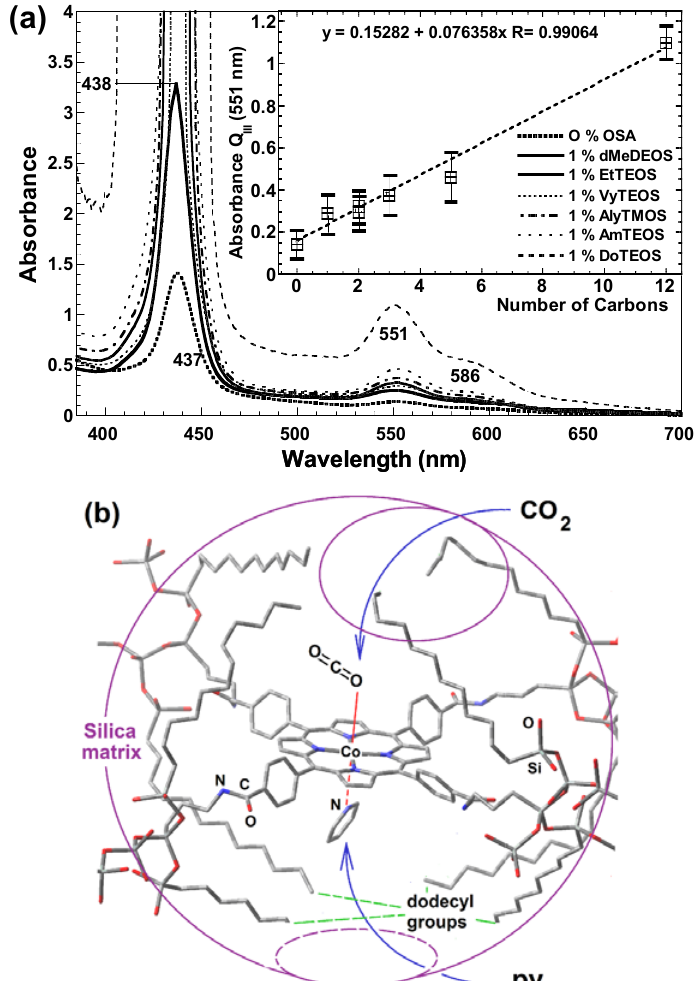
Figure 17. ( a ) In the UV-Vis spectra of CoT(p-COOH)PP bonded to the pore walls of SiO organically modified via alkyl groups the Q 2 the number of carbons of the alkyl groups attached to the silica network. ( b ) Hypothetical situation of a Co porphyrin inside a pore